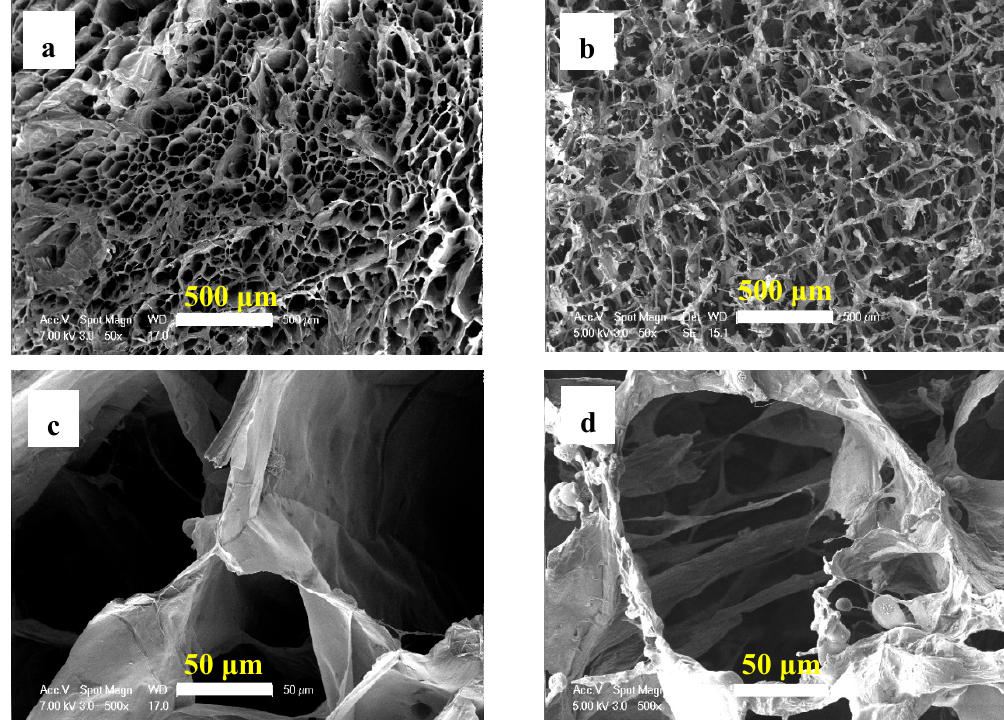
Figure 7. SEM images of the HCNF ( a , c ) and HCNF/APP/MTMS ( b , d ) aerogels.